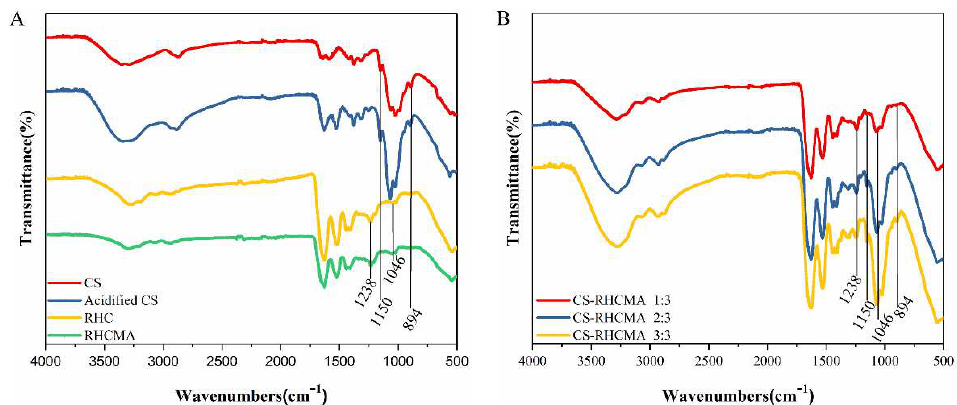
Figure 2. Characterization of functional groups of the prepared samples. ( A ) FT-IR spectra of CS, acidified CS, RHC, and RHCMA. ( B ) FT-IR spectra of CS-RHCMA with different CS to RHCMA ratios.